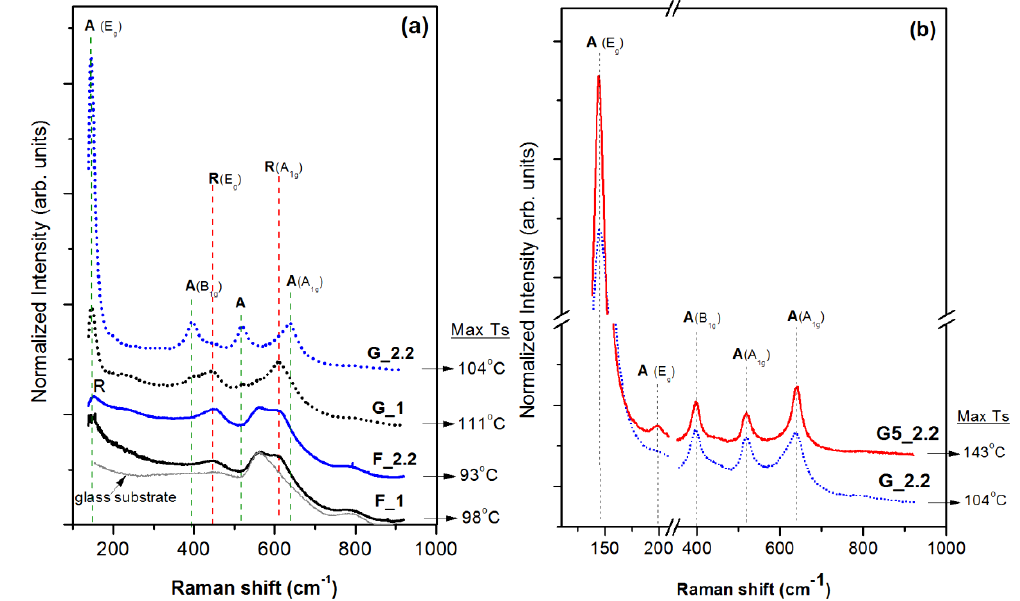
Figure 1. ( a ) Raman spectra of RF-sputtered TiO 2 films deposited at 1 mTorr and 2.2 mTorr total